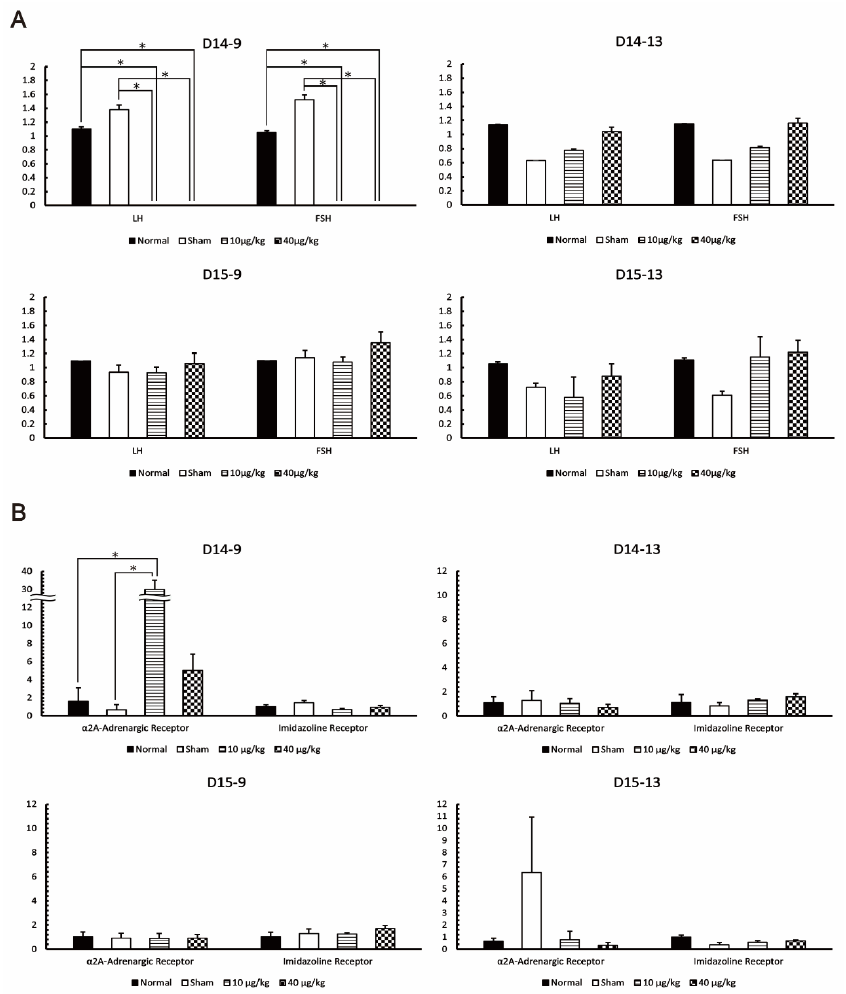
Figure 3. Effect of DEX administration on mouse pituitary gland. ( A ) The expression levels of luteinizing hormone (LH) and Follicle-Stimulating Hormone (FSH) at each pituitary gland collection point were measured by RT-PCR. ( B ) The expression levels of α2A -adrenergic and imidazoline receptors at each pituitary gland collection period were measured by RT-PCR. The values in the graph are presented as means ± SDs. * The difference was significant compared with the other group according to the statistical method of this study. The sampling points after 14 days of continuous DEX administration were 9:00 on day 14 (D14-9), 13:00 on day 14 (D14-13), 9:00 on day 15 (D15-9), and 13:00 on day 15 (D15-13).